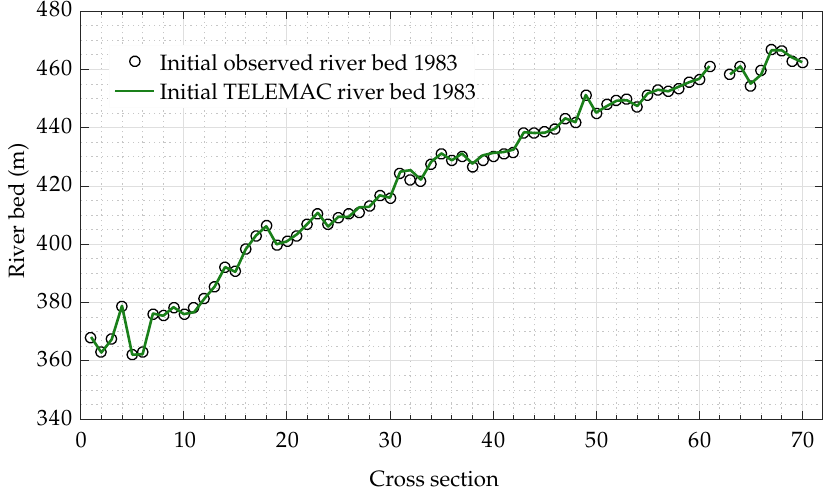
Figure 6. Mean observed and approximated river bed.